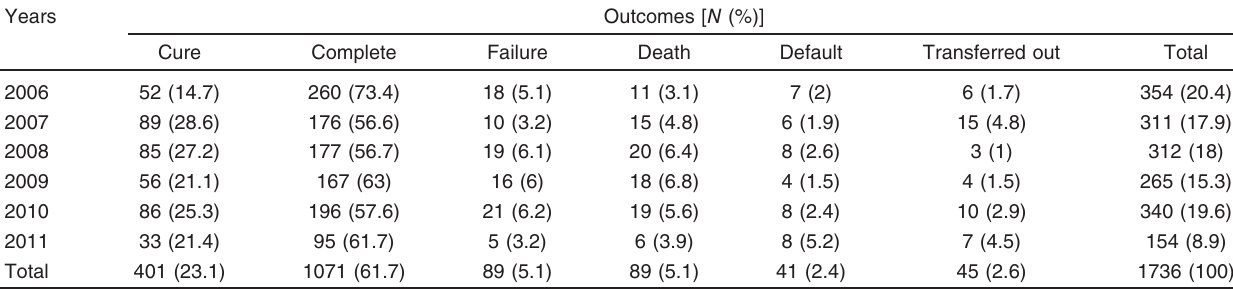
Table 7 Distribution of cases according to the treatment outcome (2006 – 2011)